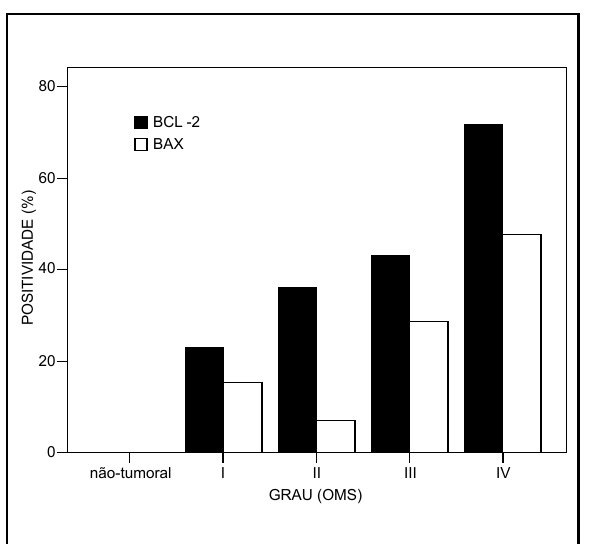
Figura 2 – Percentuais de positividade imuno-histoquímica para as proteínas BCL-2 e BAX segundo a classificação histológica dos casos avaliados